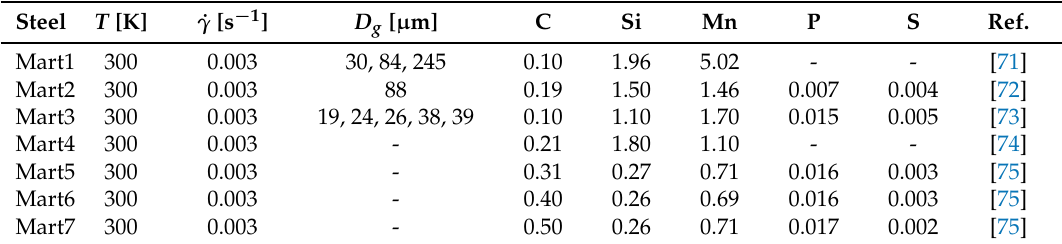
Table 2. Parameters and chemical compositions (in wt%) of martensitic